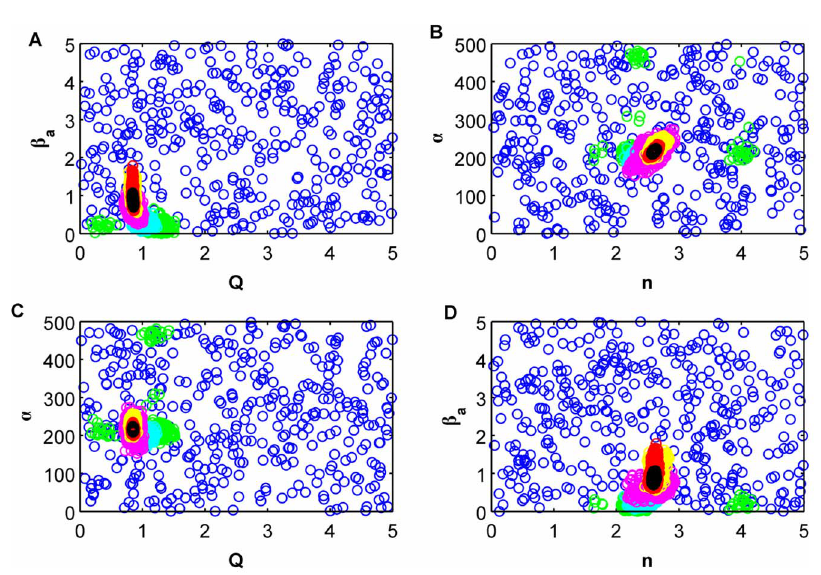
Figure 6. Two-dimensional scatterplots for the accepted particles of the ABC SMC of each population. The particles from the prior are represented in blue, particles from population 2 in green, particles from population 4 in cyan, population 6 in pink, 8 in yellow, 10 in red and particles from the posterior (population 12) in black color.